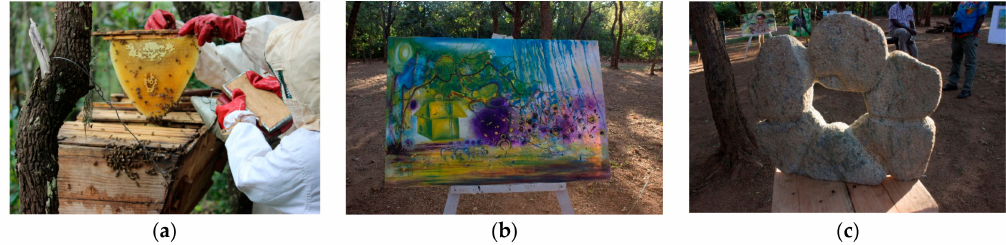
Figure 4. Misuku Hills Art Challenge: ( a ) Beekeeping training; ( b ) painting submission; ( c ) prize winning sculpture. Source: Sustainable Development